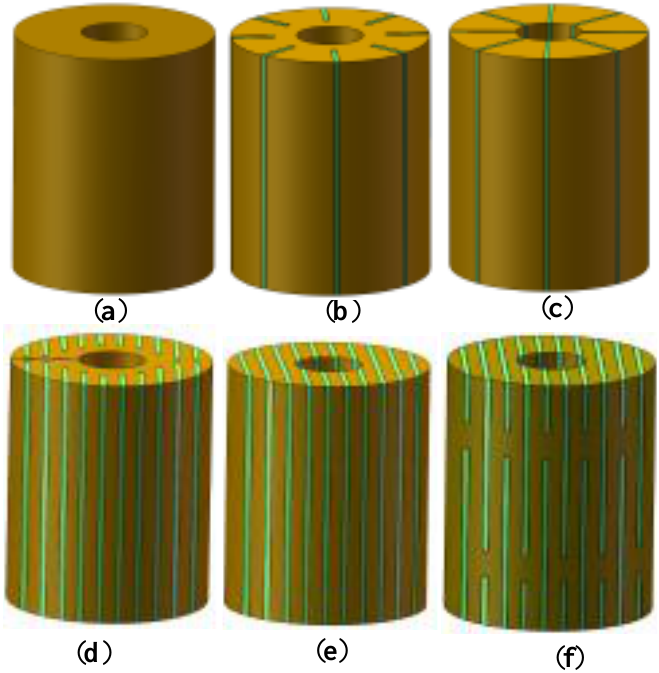
Figure 1. Structural diagram of Terfenol-D rods: ( a ) Untreated; ( b ) Radial slit; ( c ) Radial cut and bonded; ( d ) Sliced and grooved; ( e ) Slice treatment; ( f ) Sliced at both ends. bonded; ( d ) Sliced and grooved; ( e ) Slice treatment; ( f ) Sliced at both